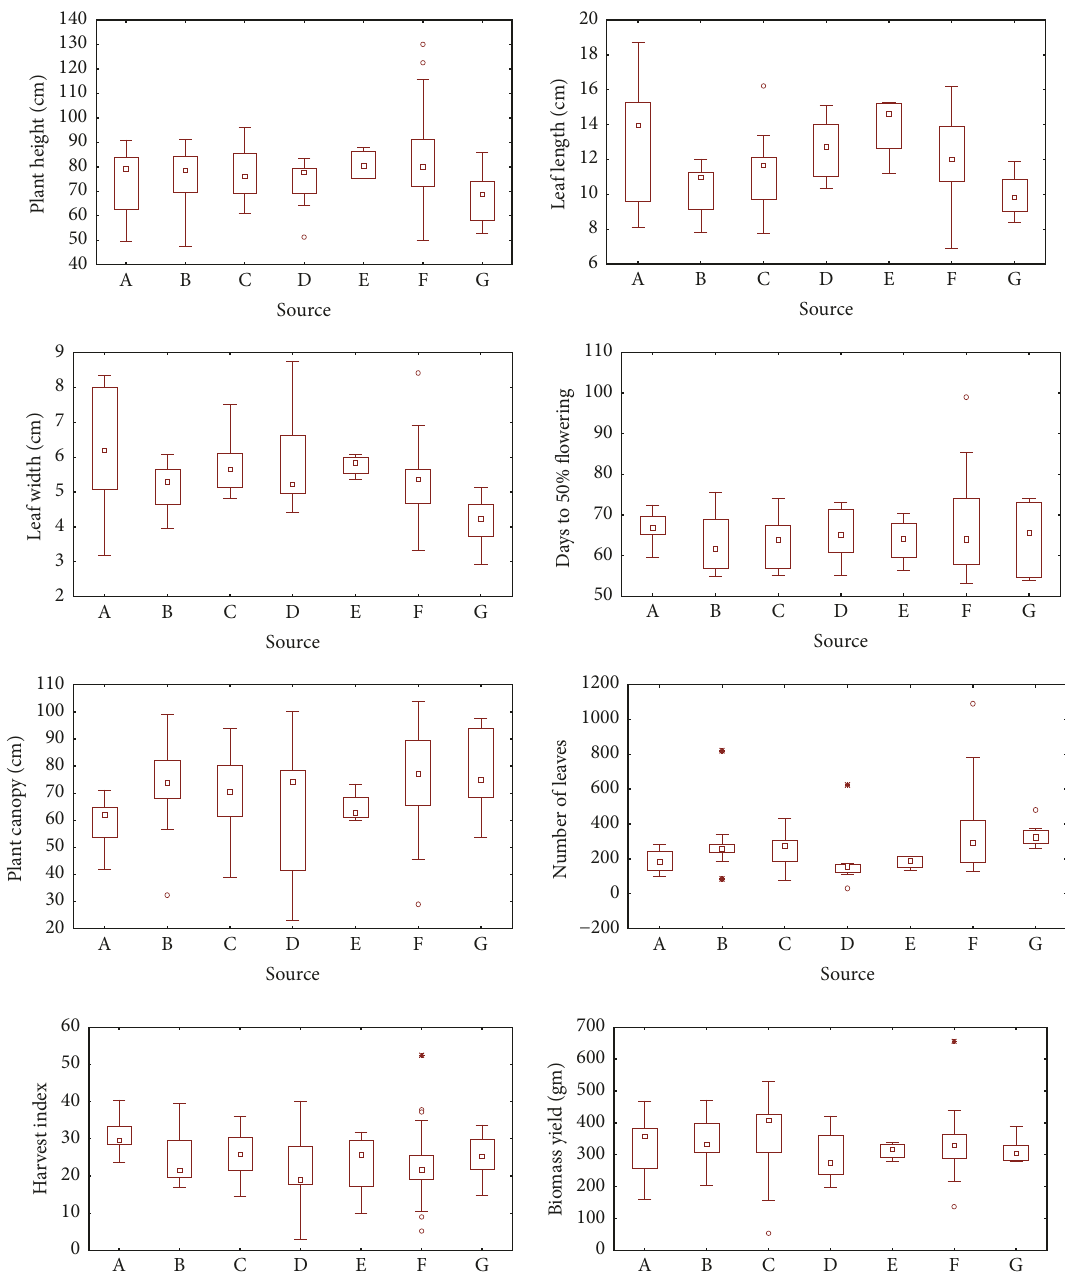
Figure 1: Box and whisker plots showing the variation in quantitative traits of the accessions from different parts: (A) West Africa, (B) East Africa, (C) South Africa, (D) unknown, (E) North Africa, (F) Southeast Asia, and (G) East Asia.